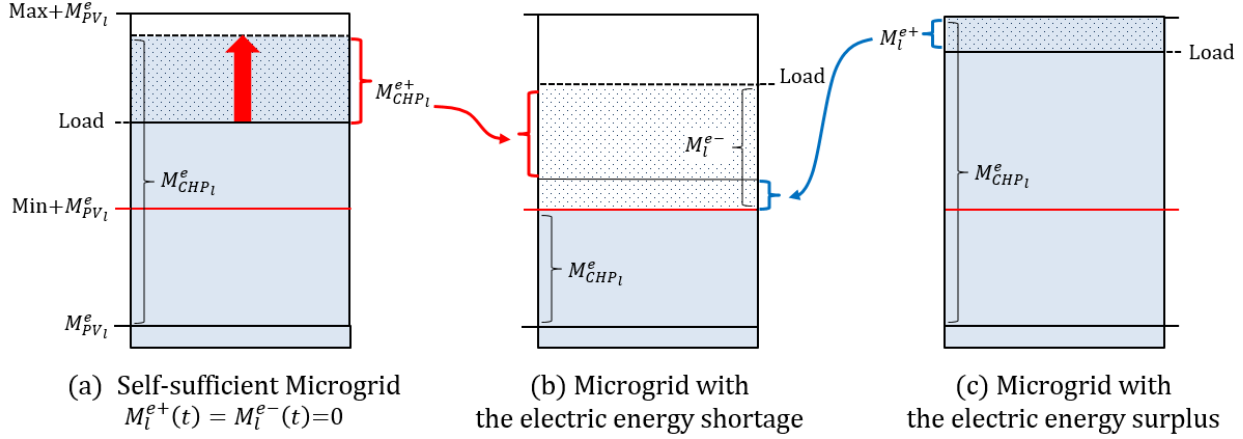
Figure 7. Example of the ancillary internal trading when ∑ (cid:1839) (cid:3039)(cid:3032)(cid:2878) (cid:4666)(cid:1872)(cid:4667) (cid:3407) ∑ (cid:1839) (cid:3039)(cid:3032)(cid:2879) (cid:4666)(cid:1872)(cid:4667) (cid:3013) (cid:3039)(cid:2880)(cid:2869)(cid:3013)